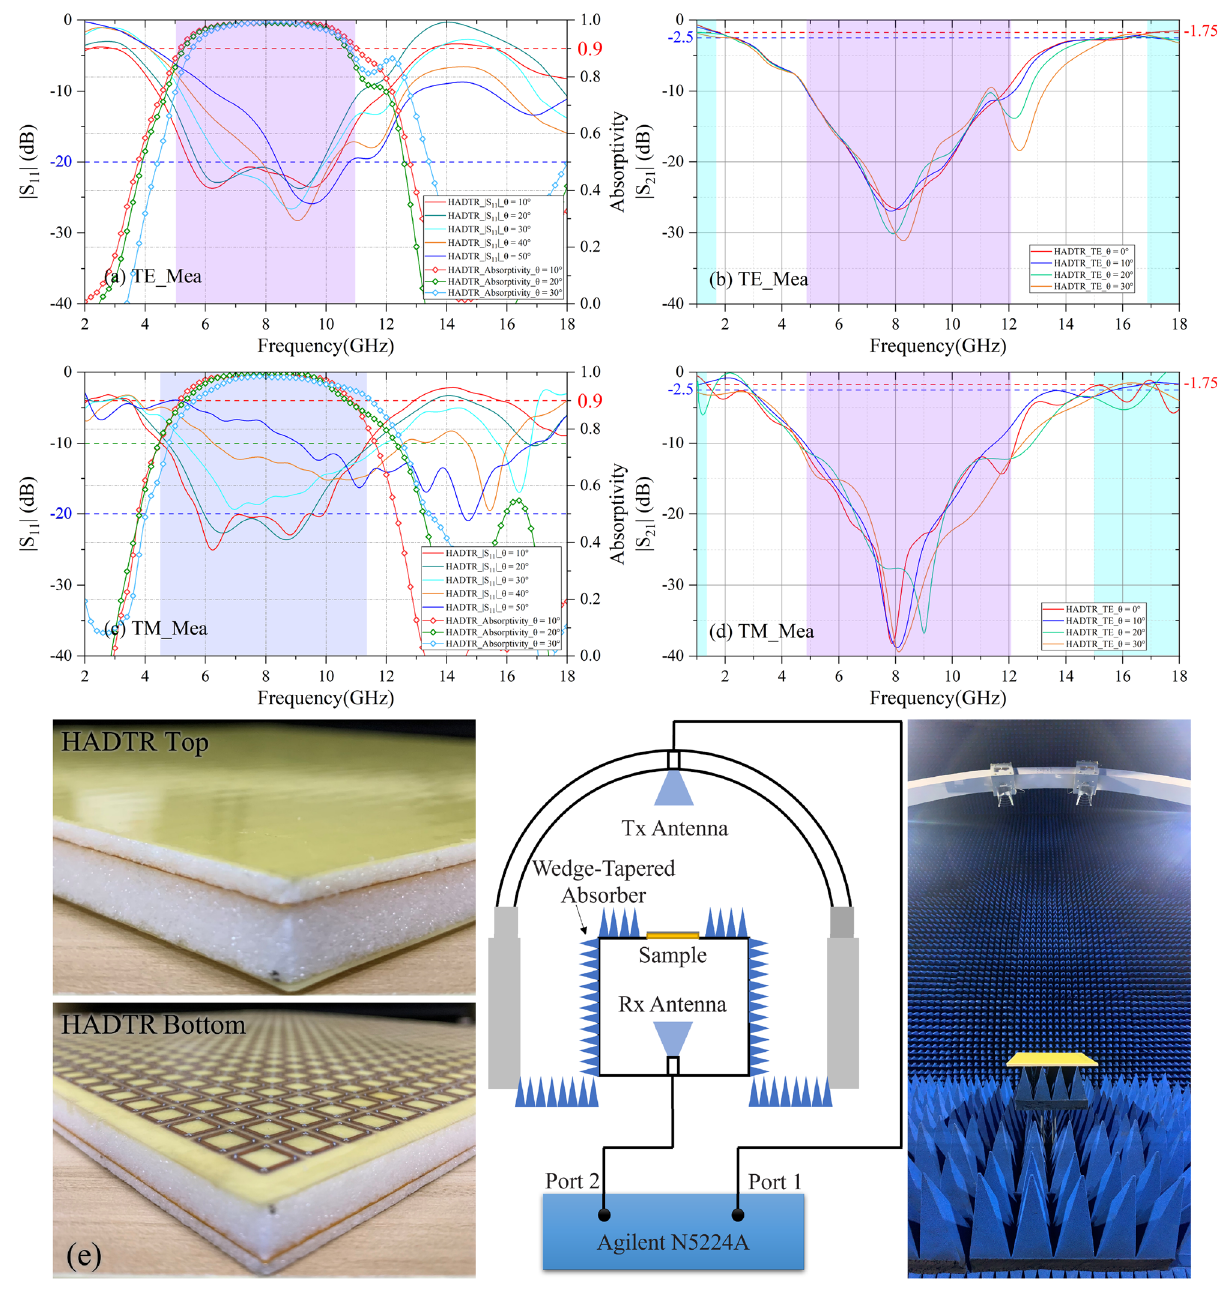
Figure 13. Measurement results the proposed HADTR. ( a ) At TE-polarization, reflection coefficients and absorptivity under different oblique incidences. ( b ) At TE-polarization, transmission coefficients under different oblique incidences. ( c ) At TM-polarization, reflection coefficients and absorptivity under different oblique incidences. ( d ) At TM-polarization, transmission coefficients under different oblique incidences. ( e) Photograph of the fabricated HADTR prototype and Measurement setup for |S 21 |/|S 11